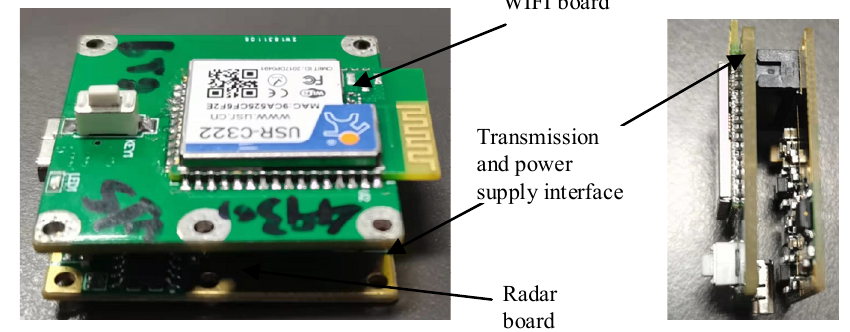
Figure 8. WiFi radar interface circuit.